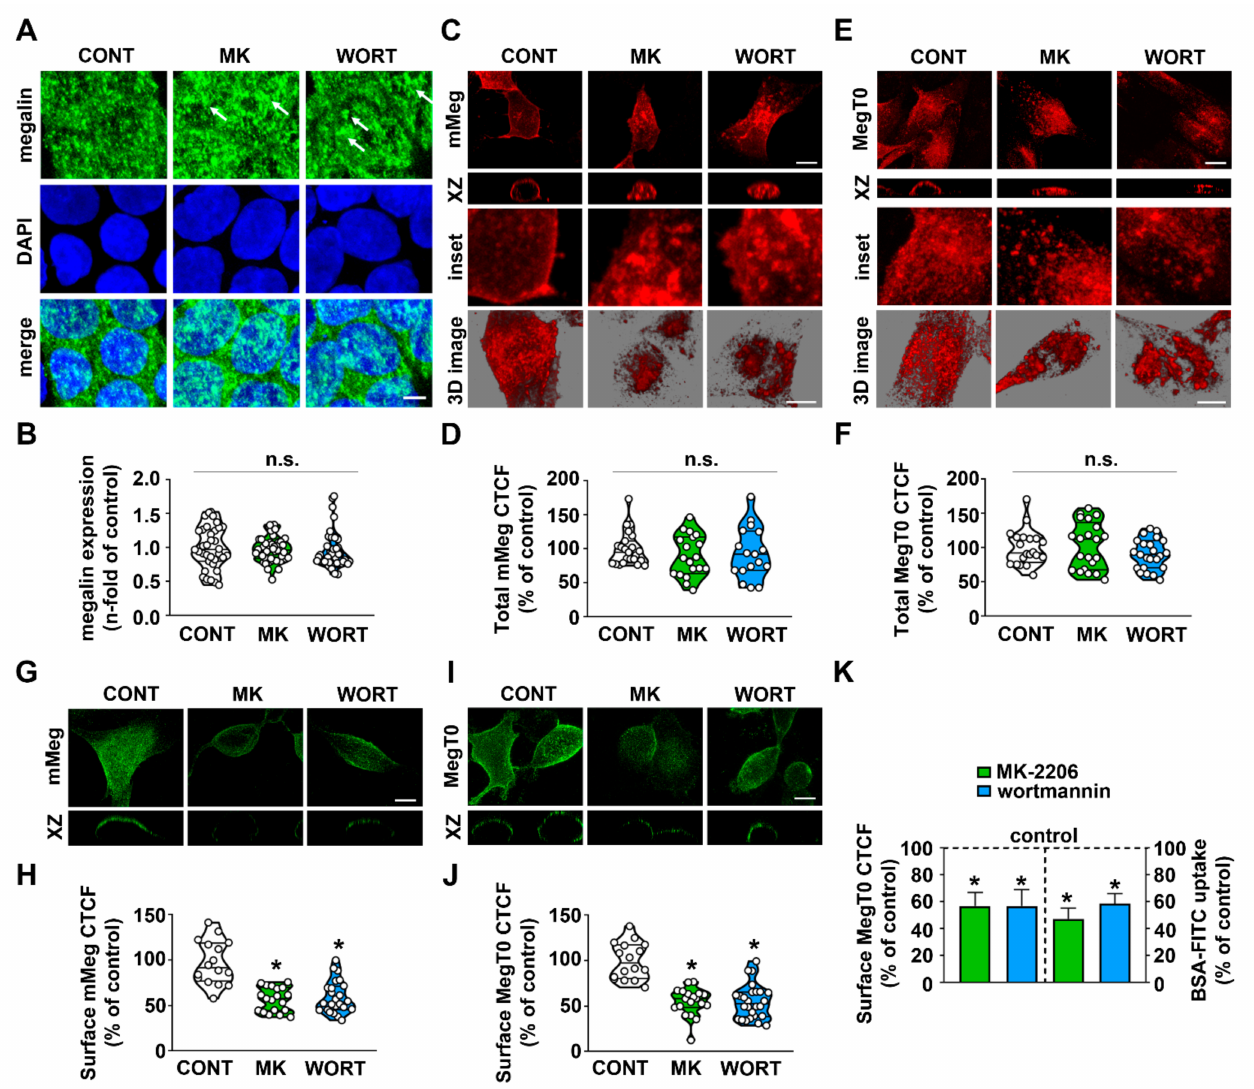
Figure 2. PI3K/AKT inhibition reduces surface megalin expression. ( A ) Representative confocal microscopy images of megalin expression (green) in LLC-PK1 cells. Nuclei were visualized with DAPI staining (blue). Cells were grown in Transwell inserts treated with 10 µ M MK-2206 (MK) or 1 µ M wortmannin (WORT) for 1 h and compared with control cells (CONT). White arrows indicate areas of megalin signal cluster. Scale bar = 5 µ m. ( B ) Quantification of megalin signal intensity